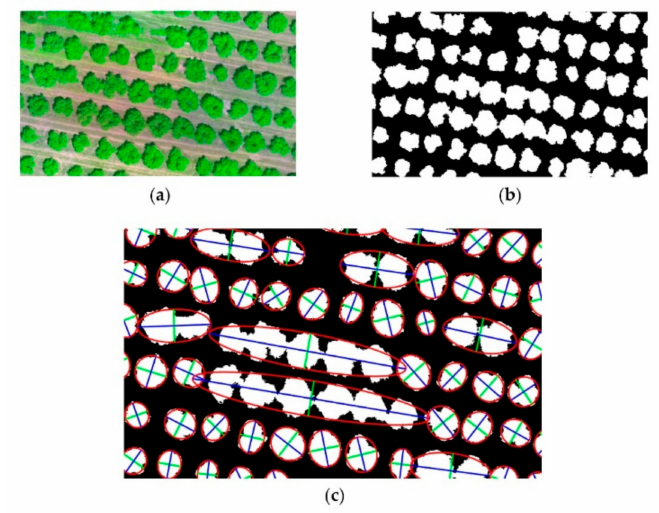
Figure 11. ( a ) Sub-image of the study plot orthomosaic represented in Figure 4; ( b ) sub-image of the binary image resulted from the segmentation performed, corresponding to the area represented in ( a ); ( c ) representation of the ellipses (in red) computed for each connected component in the image ( b ), with their corresponding major (in blue) and minor (in green)